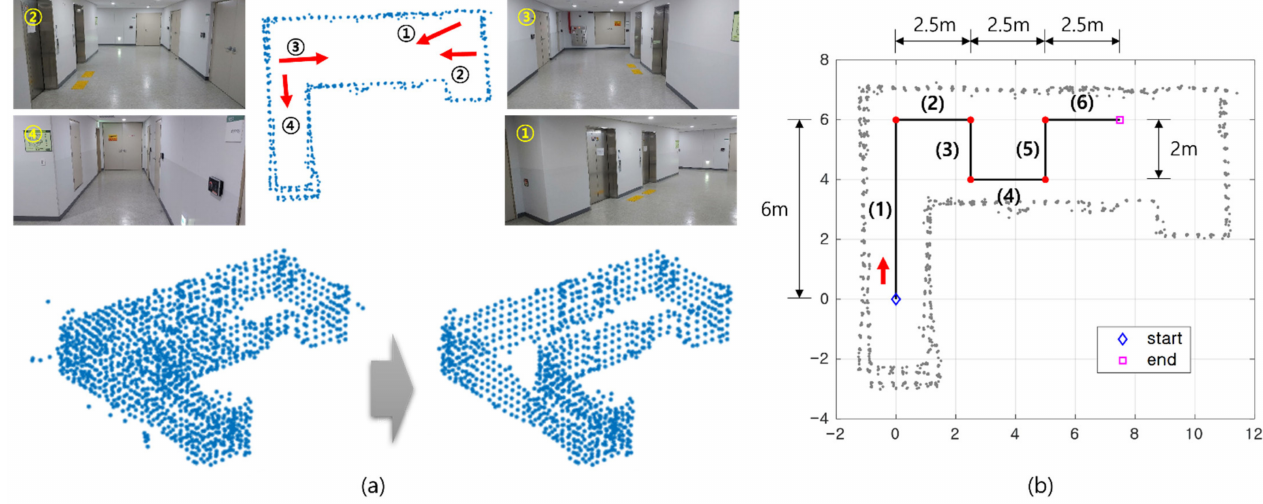
Figure 10. (a ) Experimental environment and constructed indoor map. ( b ) Vehicle trajectory composed from line segment (1) to (6) shown in the 2D